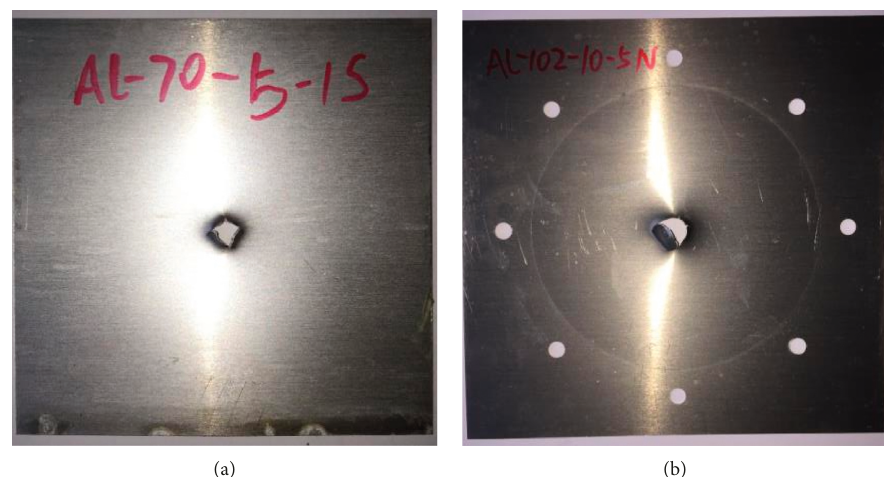
Figure 11: Failure modes of the 2A12 aluminum alloy sheet: (a) petaling under static indentation; (b) pluging under drop-weight impact.